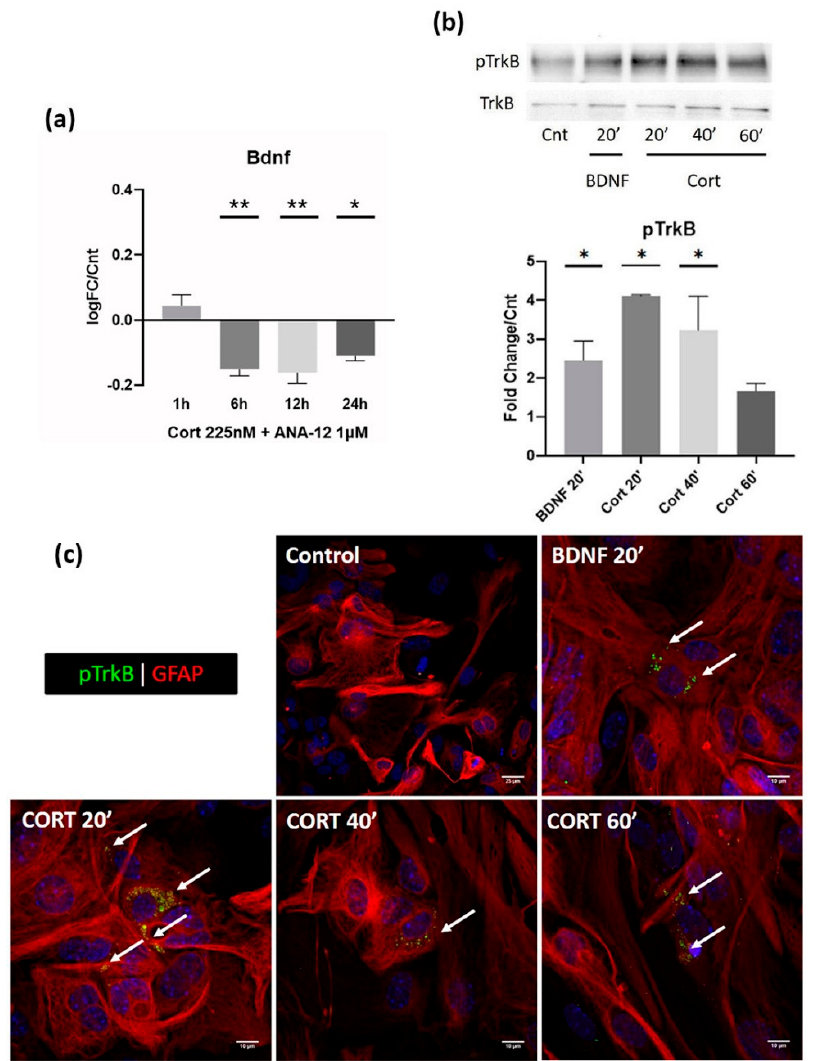
Figure 3. ( a ) ANA-12 (1 µ M) administered simultaneously with Cort (225 nM) was able to completely abolish the Cort-mediated early response on astrocytes, restoring Bdnf expression back to its baseline control levels. At the same time, ANA-12 had no effect at all on the late response at any of the tested timepoints (6 h, 12 h and 24 h). ( b ) The phosphorylation of TrkB on astrocytes was measured after Cort administration (225 nM) for 20 ′ , 40 ′ and 60 ′ with WB analysis. BDNF (500 ng/mL) administration for 20 ′ was used as a positive control of TrkB activation. Levels of phospho-TrkB are expressed as pTrkB/TrkB ratio normalized to the untreated control. Cort significantly increased pTrkB levels on astrocytes as early as 20 ′ after its administration. ( c ) Immunofluorescent staining of pTrkB (green) on astrocytes (GFAP, red) after Cort administration (225 nM) for 20 ′ , 40 ′ and 60 ′ or BDNF (500 ng/mL) administration for 20 ′ (positive control). Phosphorylation of TrkB (arrows) was profoundly more visible both in the BDNF treatment (scale bar = 10 μ m) and all the Cort treatment timepoints (scale bar = 10 μ m) compared to the control condition (scale bar = 25 μ m) where pTrkB stain was scarce. n = 3 for each experiment. * p < 0.05, ** p < 0.01; one-way ANOVA. Data are mean ± S.E.M.